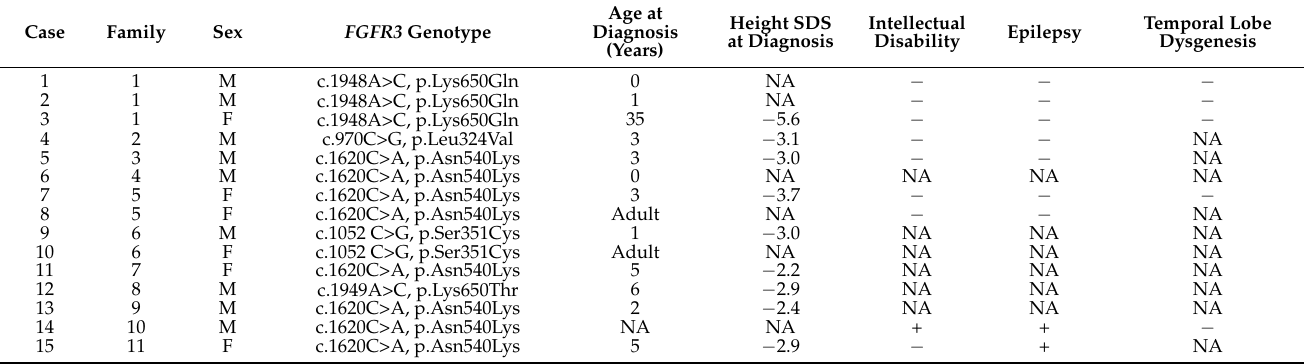
Table 1. Clinical and genetic characteristics of patients with